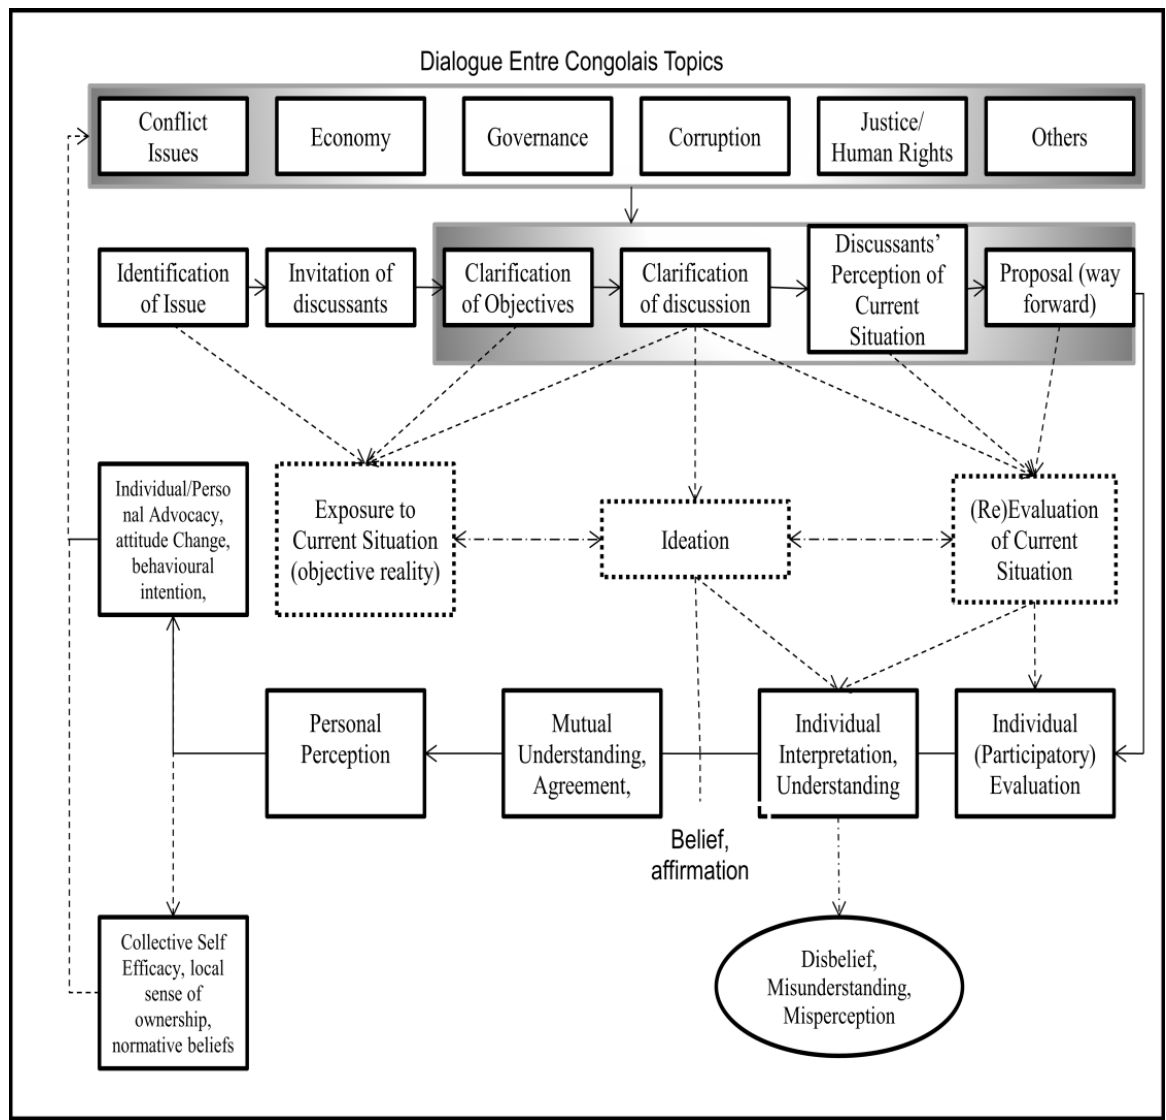
Figure 1. Process of perception change in Dialogue